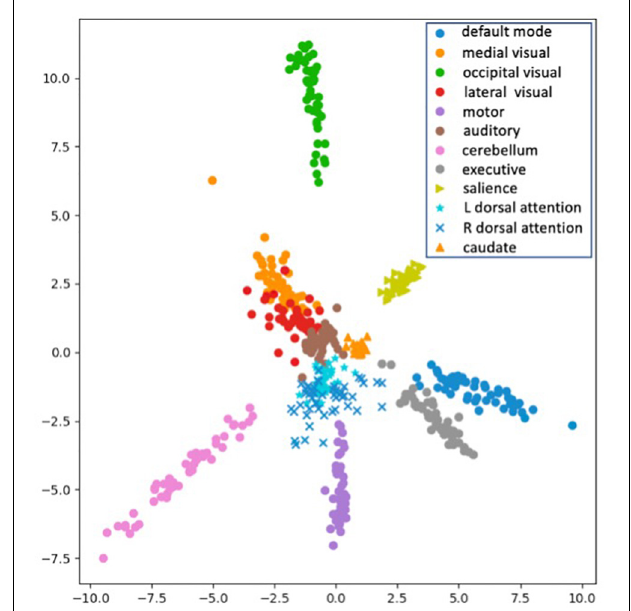
FIGURE 13 | Visualization of the embedding vectors projected down to 2-dimensions using PCA for One-Shot